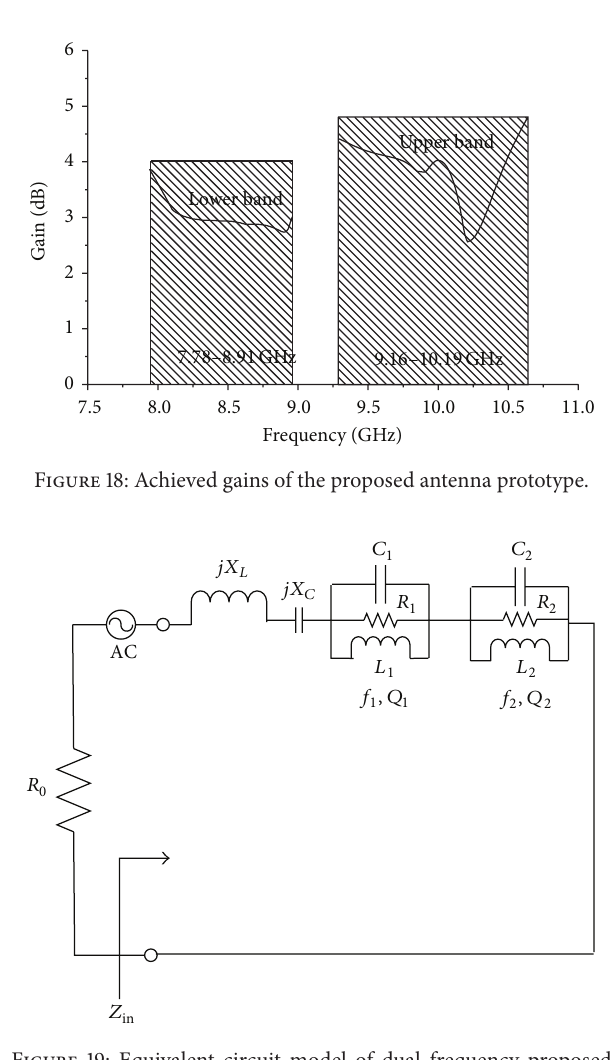
Figure 19: Equivalent circuit model of dual frequency proposed